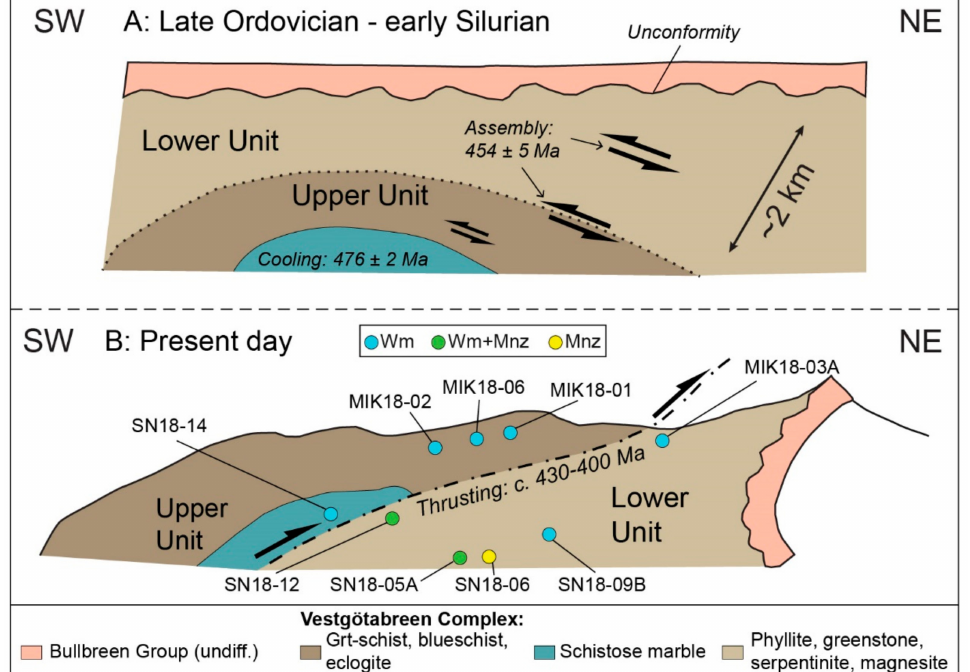
Figure 8. Schematic structural reconstructions, after Labrousse et al. [16], annotated with the geochronological ages of events constrained by this study. ( A ) The state of the Vestgötabreen Complex at Motalafjella in the late Ordovician to early Silurian, after (or during) deposition of the Bullbreen Group sediments, but prior to late Caledonian thrusting. Cooling of the Upper Unit occurred at 476 ± 2 Ma, followed by assembly of the units at 454 ± 6 Ma and then surface exposure and deposition of the Bullbreen Group in the Late Ordovician to early Silurian. ( B ) Geometry of the exposure in the present-day. Late Caledonian thrusting (c. 430–400 Ma) is depicted in association with emplacement of the Upper Unit onto the Lower Unit and deformation of the Bullbreen Group. Representative sample locations are